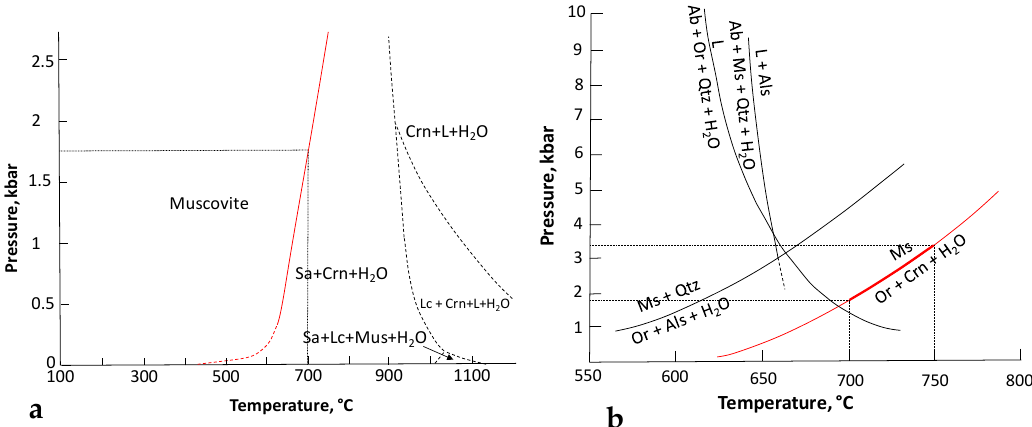
Figure 13. ( a ) The equilibrium curve (solid and dash) for the reaction Sa (sanidine) + Crn + H 2 O ⇆ Mus, estimates of the equilibrium curve for the melting of sanidine and leucite—Lc (dash) in the muscovite composition, and possible relations between the assemblages Sa + Crn + H 2 O and Mu + Sa + Lc + H 2 O are modified after [34]. ( b ) Phase relations in peraluminous granitic systems in terms of pressure and temperature after [35]. The dashed line is a metastable extension of the reaction Ab (albite) + Ms (muscovite) + Qtz (quartz) + H 2 O = melt + aluminum silicate to 2 kbar pressure. The H 2 O-saturated haplogranite solidus (Ab + Or (orthoclase) + Qtz + H 2 O = melt) and the subsolidus second sillimanite isograd (Ms + Qtz = Or + aluminum silicate + H 2 O) were determined by [36] and [37]. The terminal muscovite reaction Ms = Or + Crn + H 2 O comes from [35]. The diagram was modified after [33].